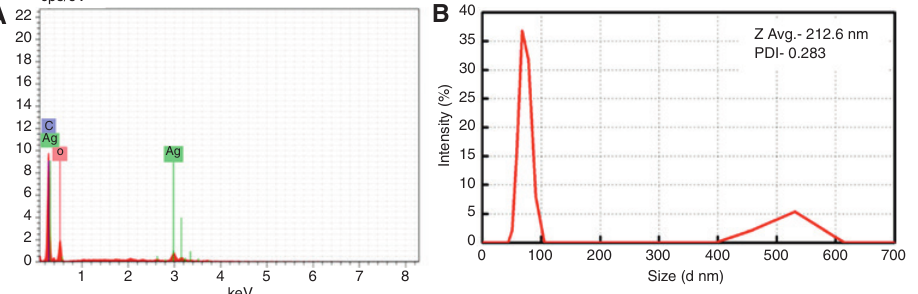
Figure 3: Representative (A) energy dispersive X-ray spectroscopy (EDX) and (B) dynamic light scattering (DLS) intensity versus size spectra of silver nanoparticles